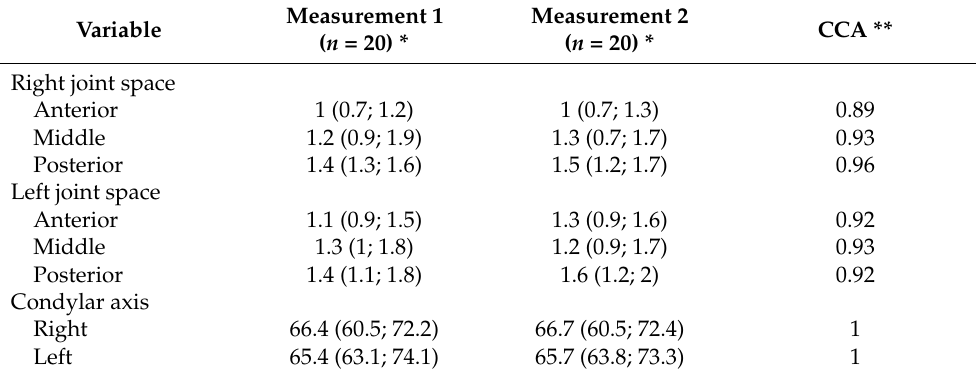
Table 2. Intraobserver agreement for patients treated during the period 2015–2020 with CT indicated due to